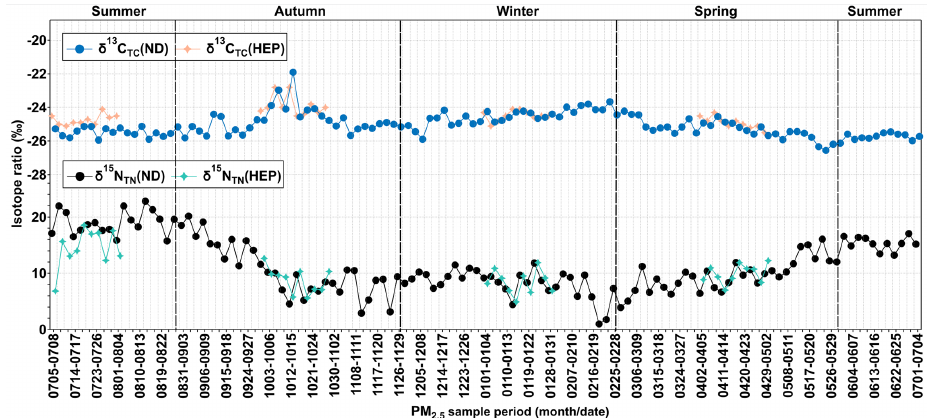
Figure 8. Temporal variations in δ 13 C TC and δ 15 N TN in PM 2 . 5 at ND (solid dots) and HEP (solid stars) in Tianjin during the campaign period (2018–2019).